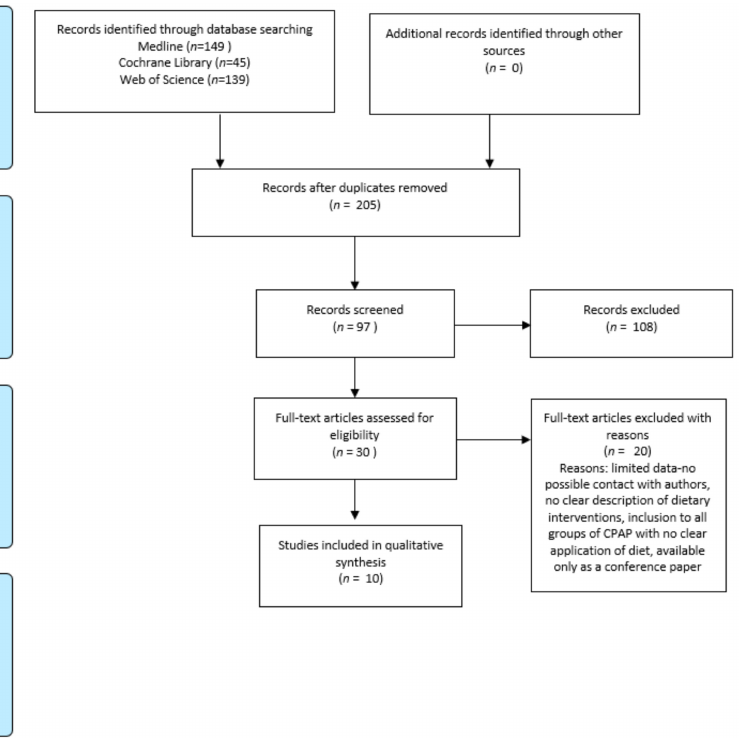
Figure 1. Process of the literature search for dietary intervention and cardio-metabolic risk factors in